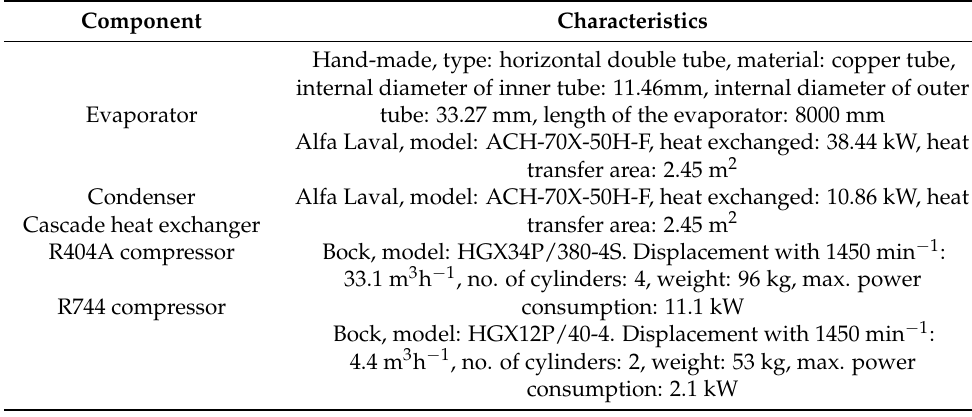
Table 3. Main components of the experimental apparatus for the CRS.